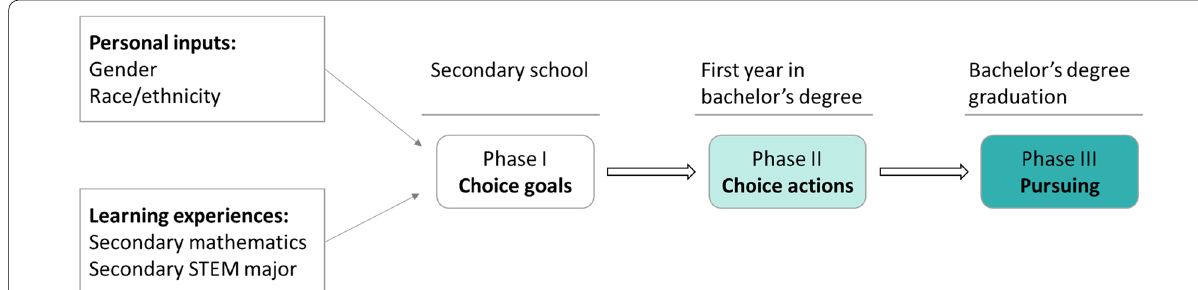
Fig. 2 The study model, based on the CSM model of Lent and Brown